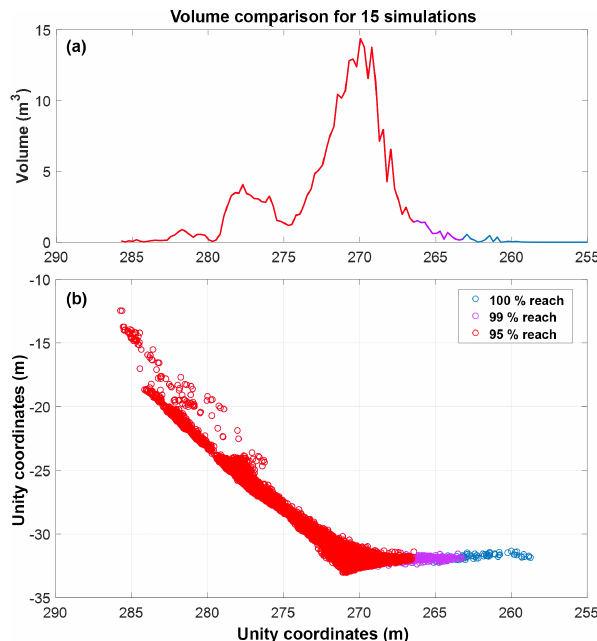
Figure 19. A section view of the 15 simulation iterations run for the 24m 3 wedge sliding event at White Canyon East, Site B. (a) shows the accumulation of simulated fragments across the section. The notable peak visible at 270m is in alignment with the location of the track-side catchment ditch, as shown in (b)